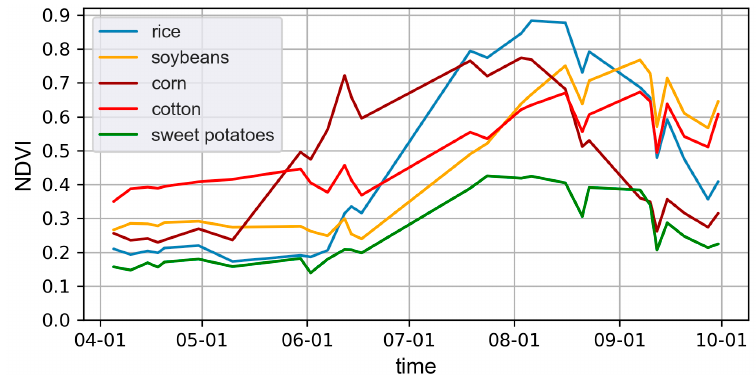
Figure 13. NDVI values for different classes of pixels over 1 April 2020–30 September2020.